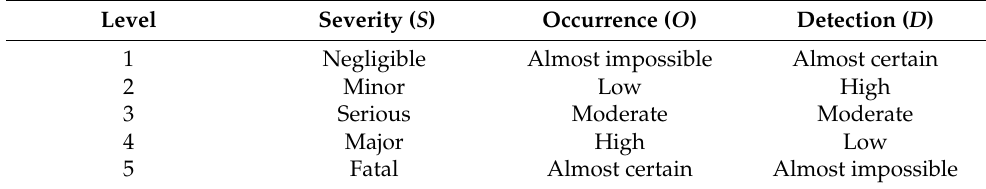
Table 1. Evaluation of the three failure mode and effect analysis (FMEA) factors. Level Severity ( S ) Occurrence ( O ) Detection ( D ) 1 Negligible Almost impossible Almost certain 2 Minor Low High Serious Moderate